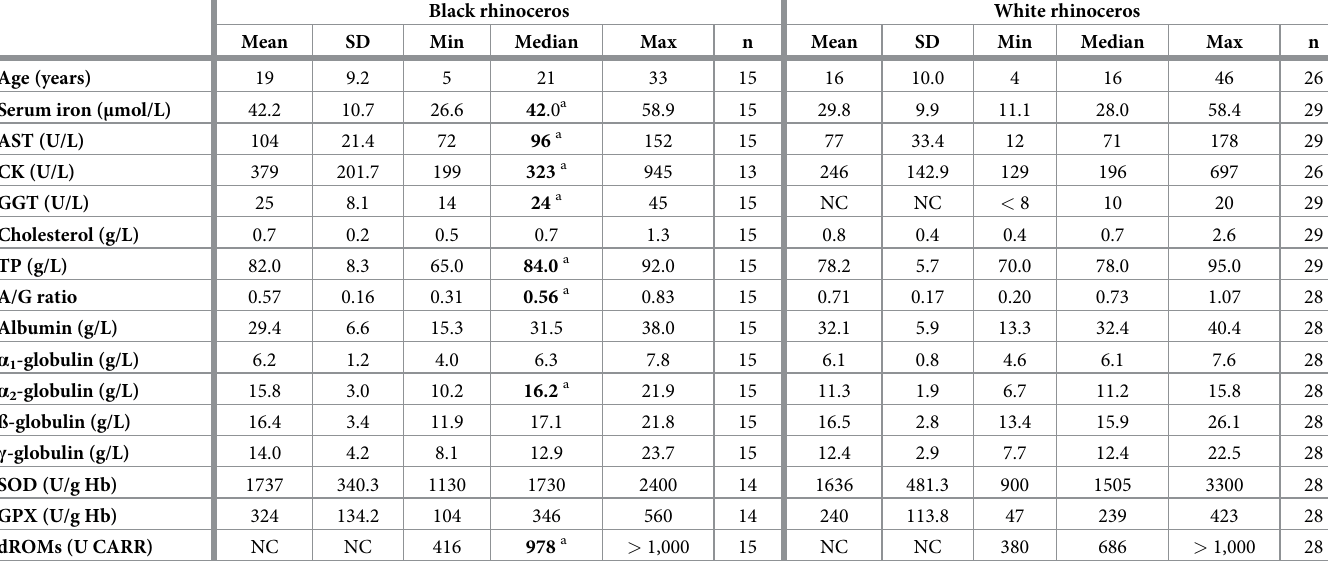
Table 1. Results for parameters measured in European captive black and white rhinoceroses for the evaluation of iron status, hepatic and muscular function, inflammation status and oxidative stress levels. Black rhinoceros White